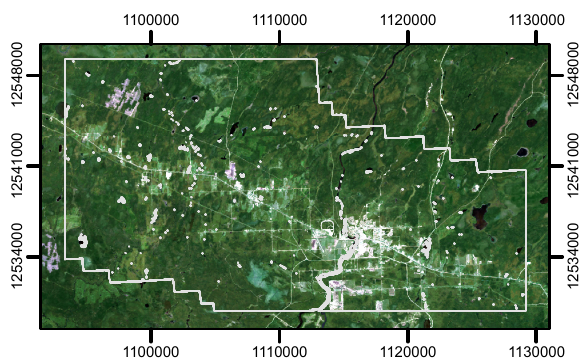
Figure 6. True-color composite image of the study area from Landsat-8 imagery from the summer of 2017.